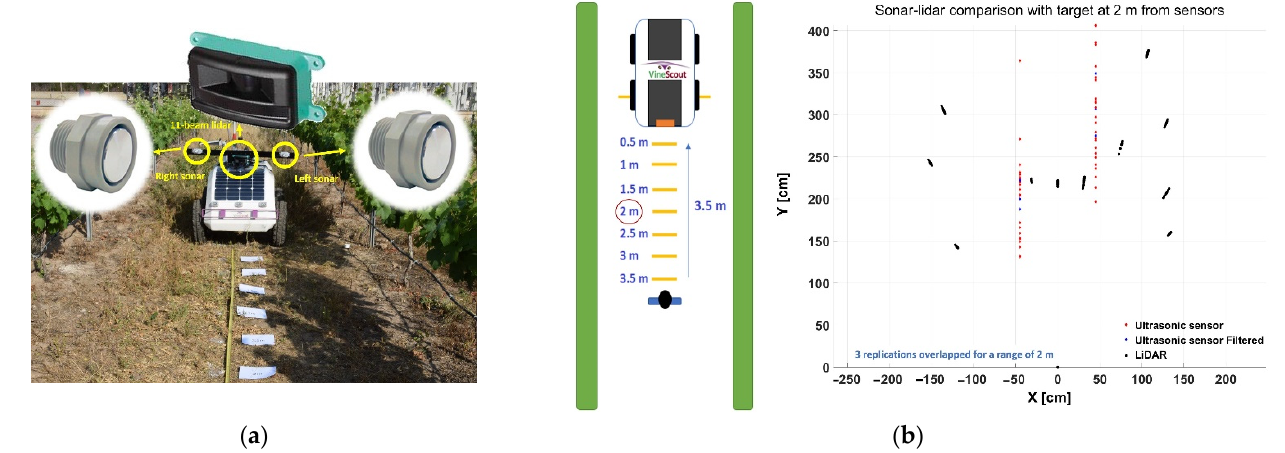
Figure 3. Comparison between ultrasonic and lidar rangefinders in relevant environments: ( a ) experimental setup; and ( b ) results.